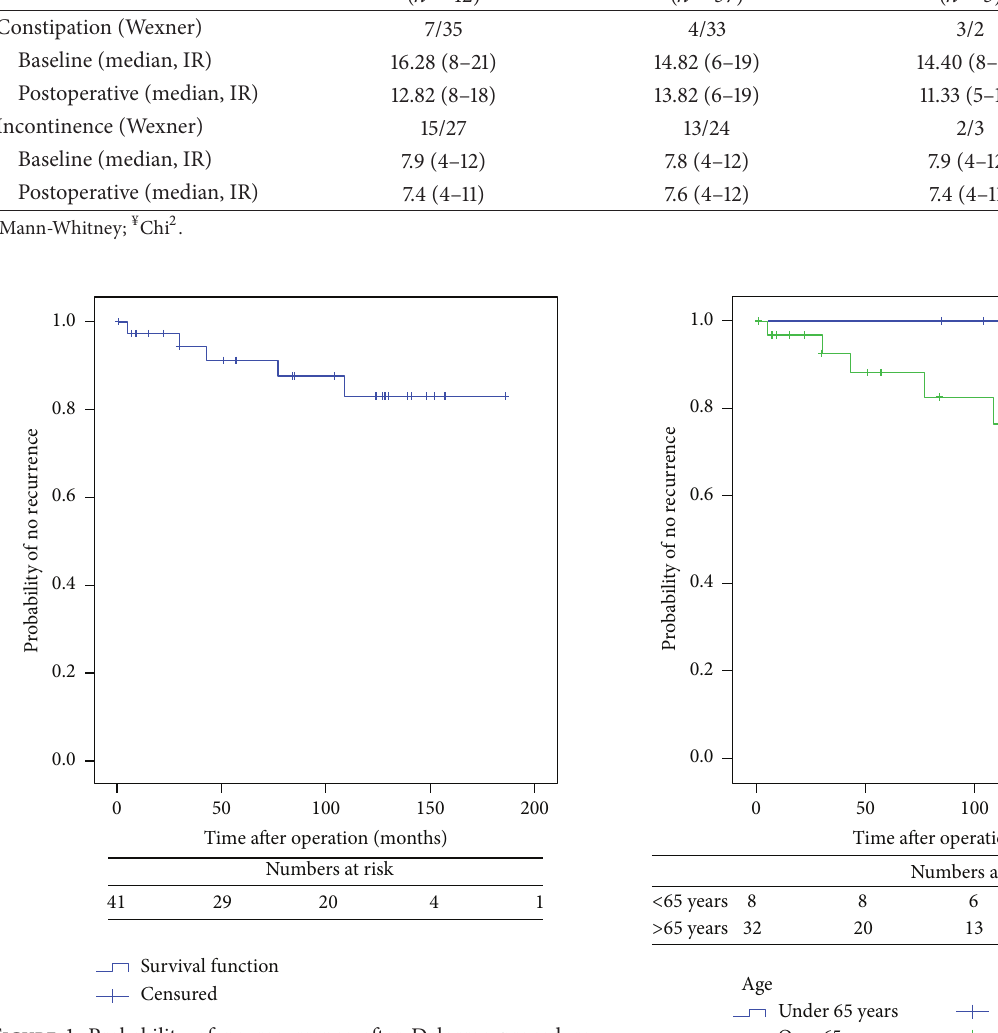
Figure 1: Probability of no recurrence after Delorme procedure (Global series).